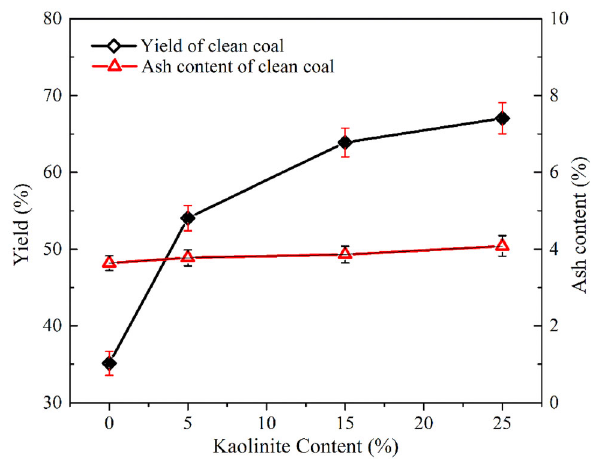
Fig. 10 Flotation experimental clean coal yield and ash content results for different contents of